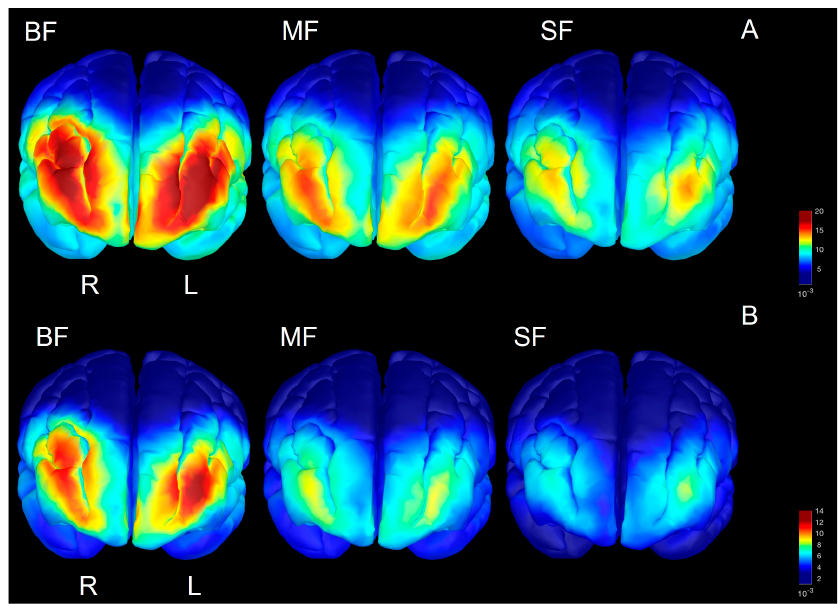
Figure 3. Power spectra distribution of beta ( A ) and gamma ( B ) in two-month-olds based upon dietary group. Greater prefrontal activation is observed in BF vs. SF groups in both high frequency bands.